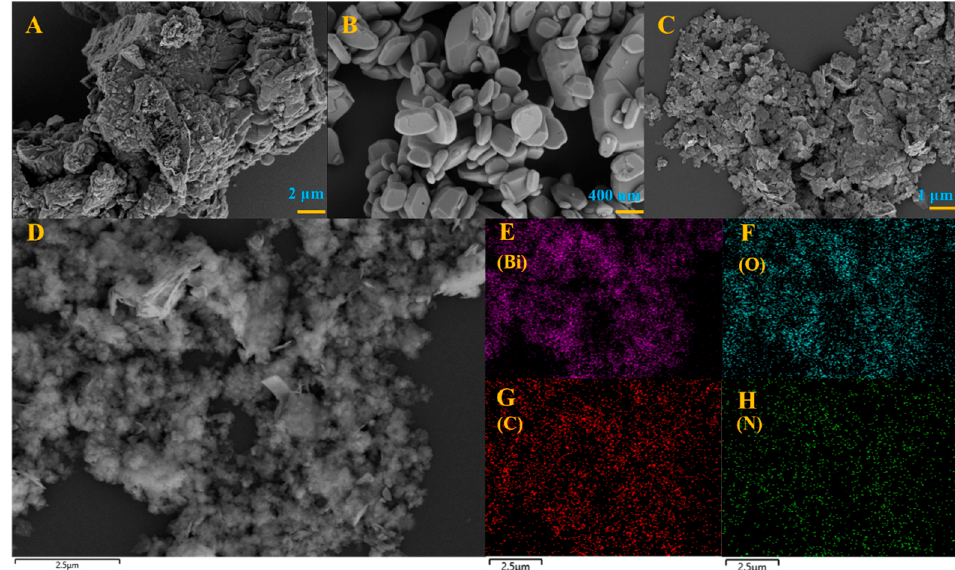
Figure 1. The SEM of BOC ( A ), CN ( B ) and BOC-CN-Bi ( C , D ), the mapping image of BOC-CN-Bi in ( E ) (Bi), ( F ) (O), ( G ) (C) and ( H ) (N).